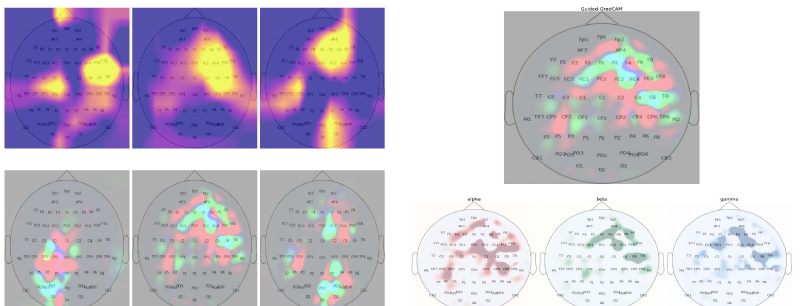
Figure 5. ( Left ) Examples of GradCAM activation maps (1st row) and their corresponding pixel-space feature map from Guided-GradCAM (2nd row). GradCAM activation maps show some noise as evident by activation in the background. In contrast, the pixel-space activation maps show more noise-free and detailed feature activation. ( Right ) Band-specific spatial activation from Guided- GradCAM. The red, blue, and green color channels of the pixel-space activation map correspond to the learned spatial feature importance of α , β , and γ frequency